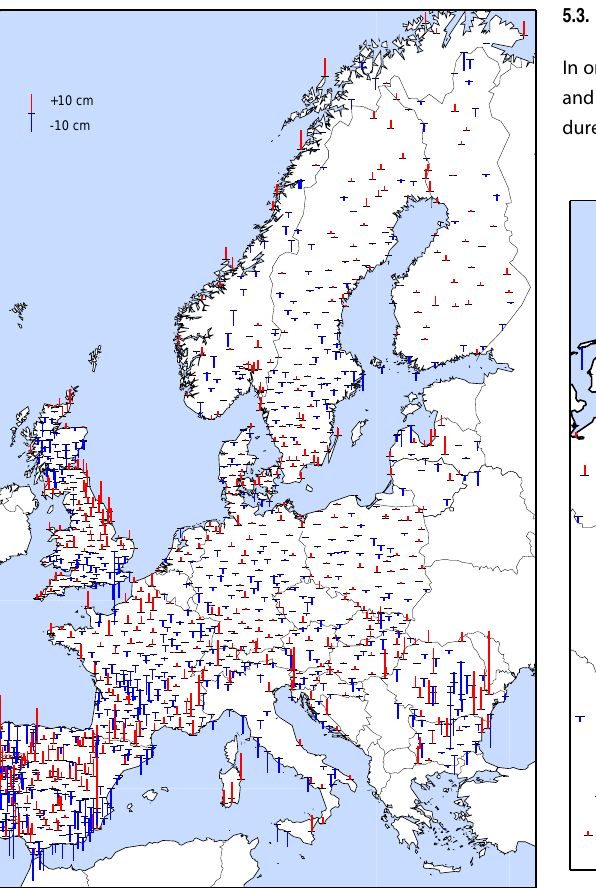
Figure 5. Residuals of observed height anomalies at European GNSS/leveling points vs. plane model computed with the GF approach. The filter-combined GOCO03S+EGG2008 model has been used as the gravity field model.